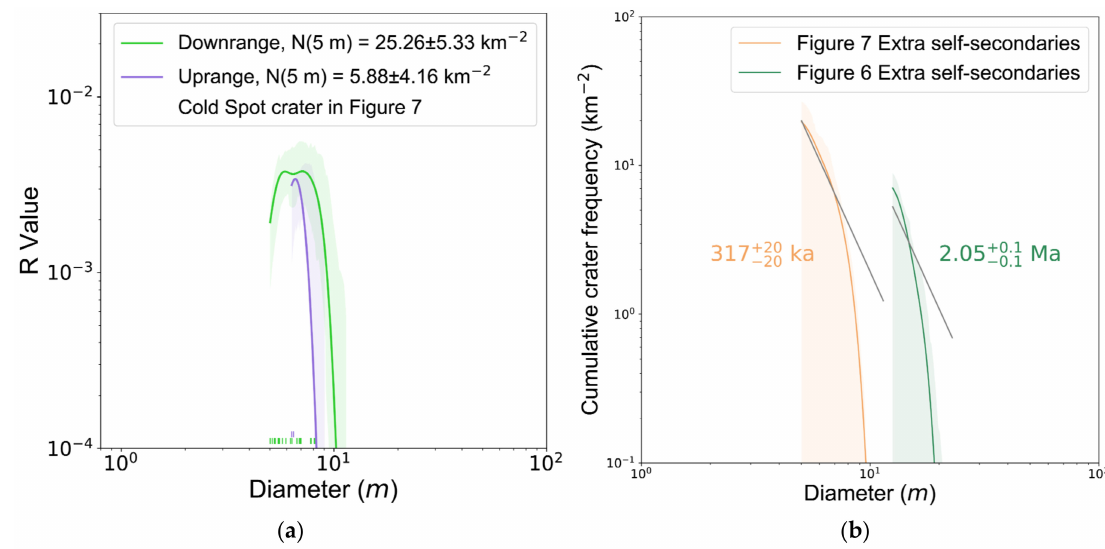
Figure 8. Crater size-frequency distribution of the extra self-secondaries that were formed on the downrange ejecta but not on the uprange. Crater populations superposed on the two cold spot craters shown in Figures 6 and 7 are used in this calculation. ( a ) Crater SFDs on the uprange and downrange ejecta deposits of the cold spot crater shown in Figure 7a. ( b ) SFD differences of crater populations on the downrange and uprange ejecta of the cold spot craters shown in Figures 6 and 7. The equivalent absolute model ages for the two populations of extra self-secondaries are estimated based on the updated crater production [17] and chronology [9]